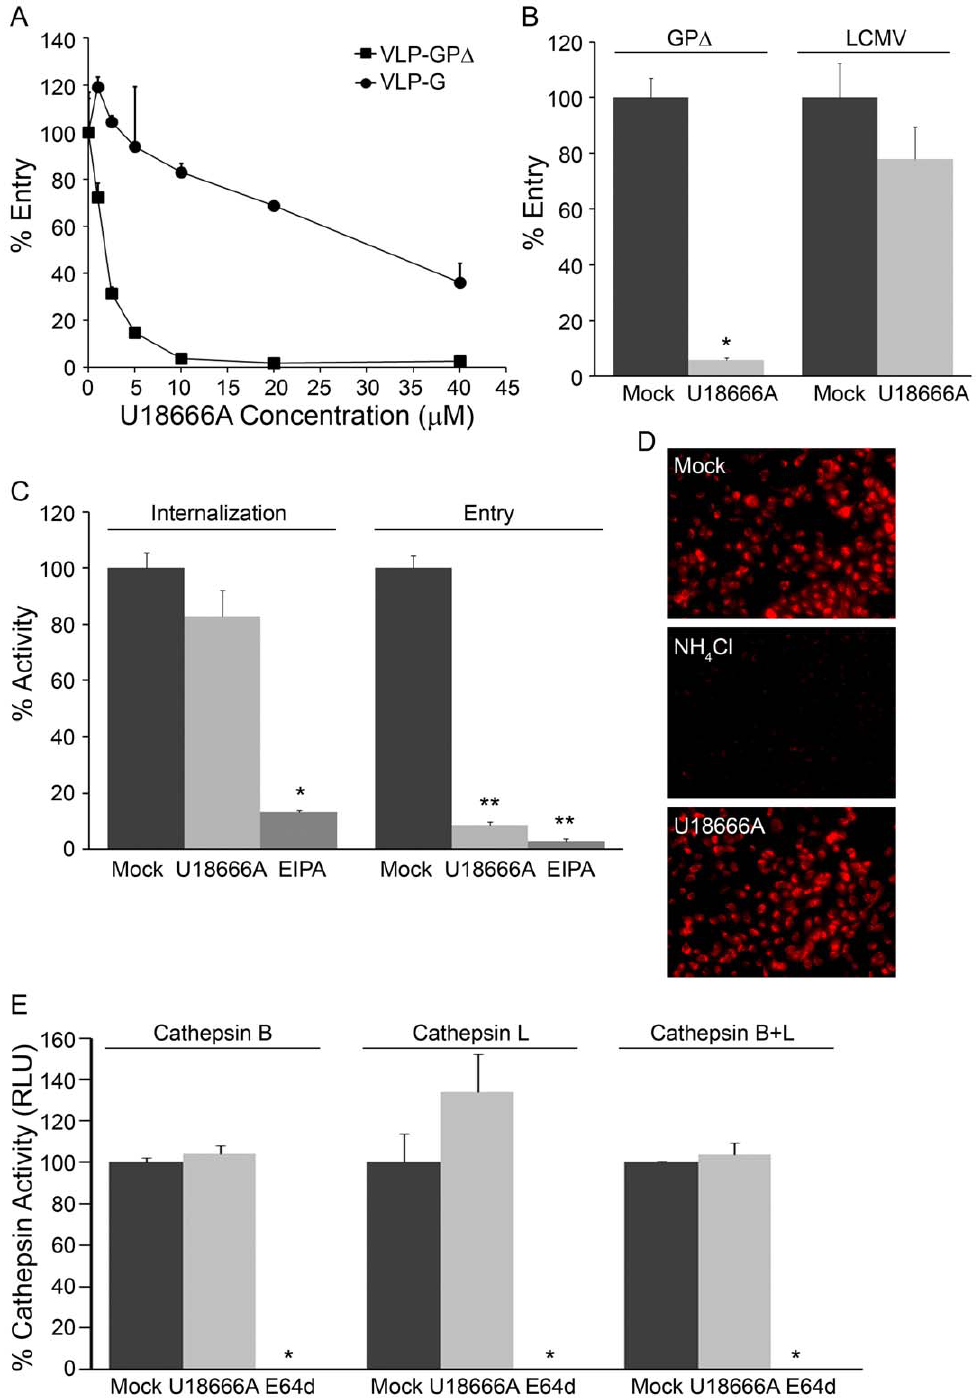
Figure 4. U18666A inhibits EBOV entry at a post internalization step and does not inhibit endosome acidification or cathepsin levels. Effects of U18666A (indicated concentration in A, 5 m M in B-E) on: (A) VLP-GP D and VLP-G entry; one representative of two experiments (done in triplicate). (B) VLP-GP D and VLP-LCMV entry; one representative of three experiments (done in duplicate). (C) VLP-GP D internalization and entry (controls as in Fig. 3C); one representative of two experiments (done in triplicate). (D) Endosomal pH detected by Lysotracker Red; 10 mM NH 4 Cl was used as the control for pH neutralization; representative images from multiple coverslips from a single experiment (E) Cathepsin B, L, and combined B/L activity; E64d was used as the positive control as in Fig. 3E; results from a single experiment performed in duplicate. In all assays, SNB19 cells were pre-treated with the indicated concentration of inhibitor for 1 hr at 37 u C, and inhibitors were maintained throughout the assays. Error bars represent standard deviation from the mean of mock-treated samples: * (P , .01), ** (P , .001), or *** (P , .0001).